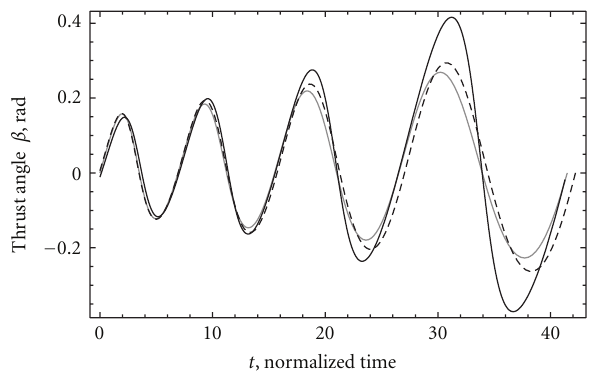
Figure 5: Thrust angle comparison of di ff erent trajectories in case